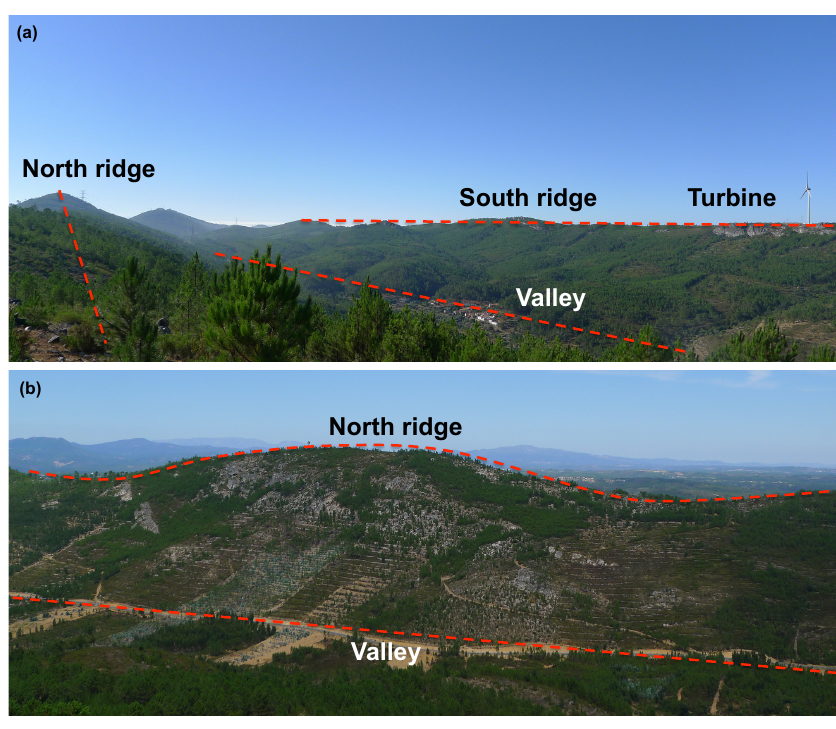
Figure 2. Perdigão site in September 2014 (see Vasiljevi´c, 2014a). Views from the north ridge (a) and south ridge (b) .